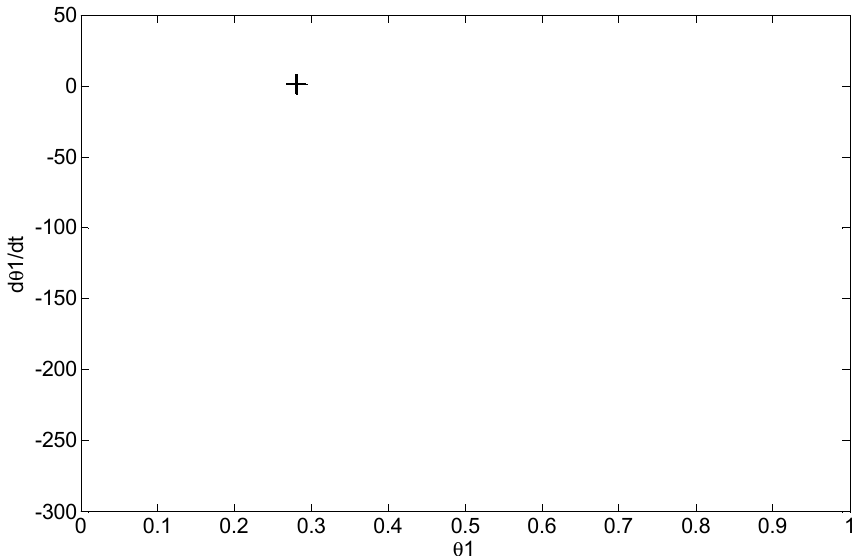
Figure 16. Poincaré plane of superficial fractional coverage of carbon monoxide at P 1 = 140 Pa and a period of 1.599 s.